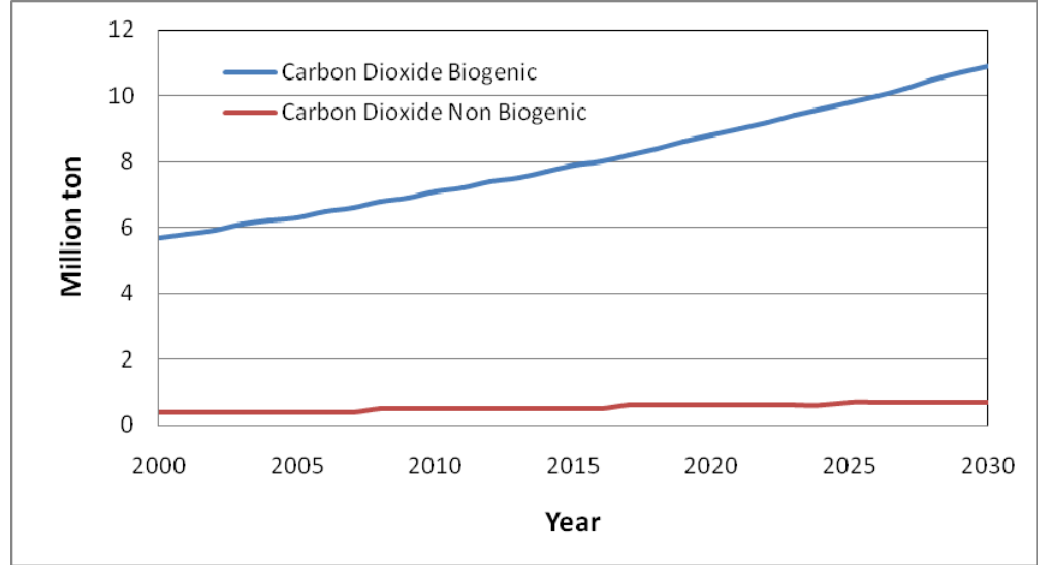
Figure 4. Global warming potential due to rice processing in Bangladesh